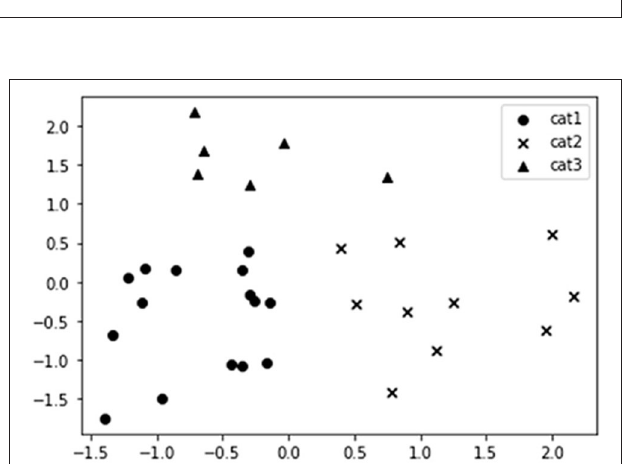
FIGURE 2 | Cluster category evaluation index.